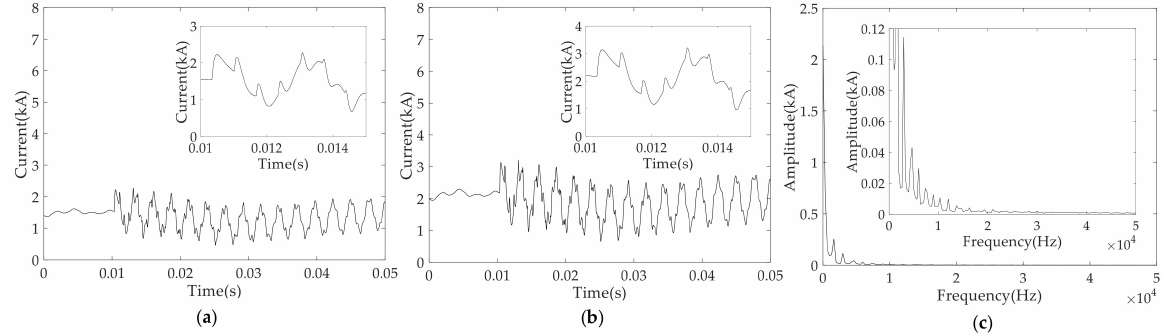
Figure 7. Transient characteristics of a lightning disturbance (LD). ( a ) Current waveform; ( b ) current line mode component waveform; ( c ) spectrum analysis.